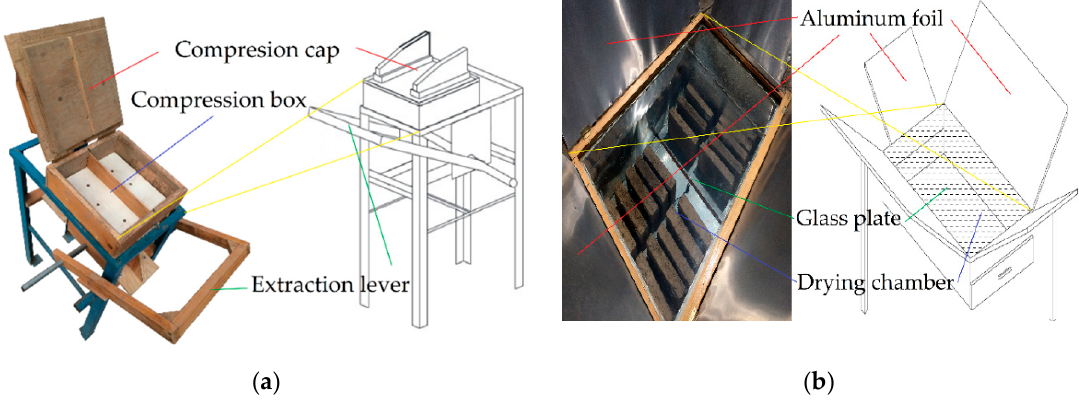
Figure 3. ( a ) Configuration of brick making machine; ( b ) Desiccator.